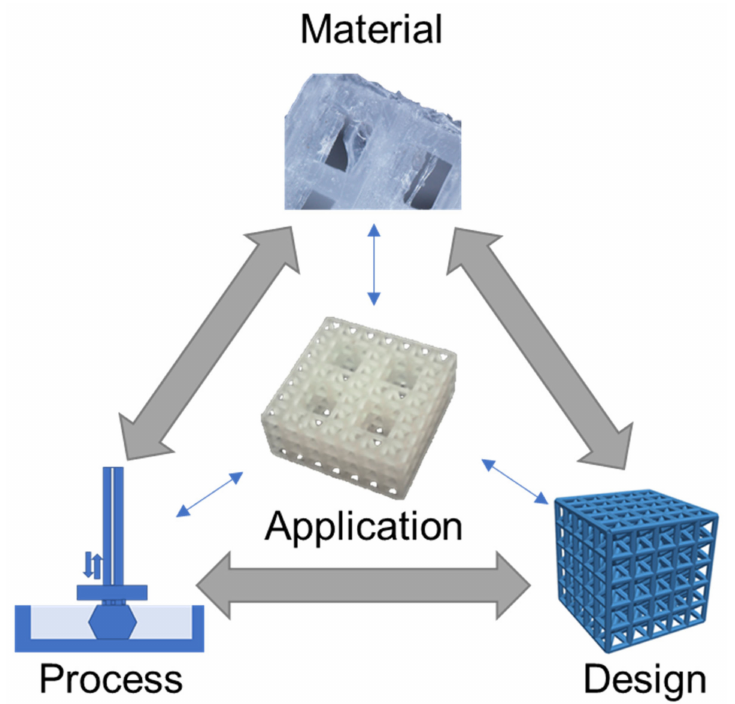
Figure 1. Material, process, and design considerations for medical applications, illustrated for a tissue scaffold example [17]. Images adapted with